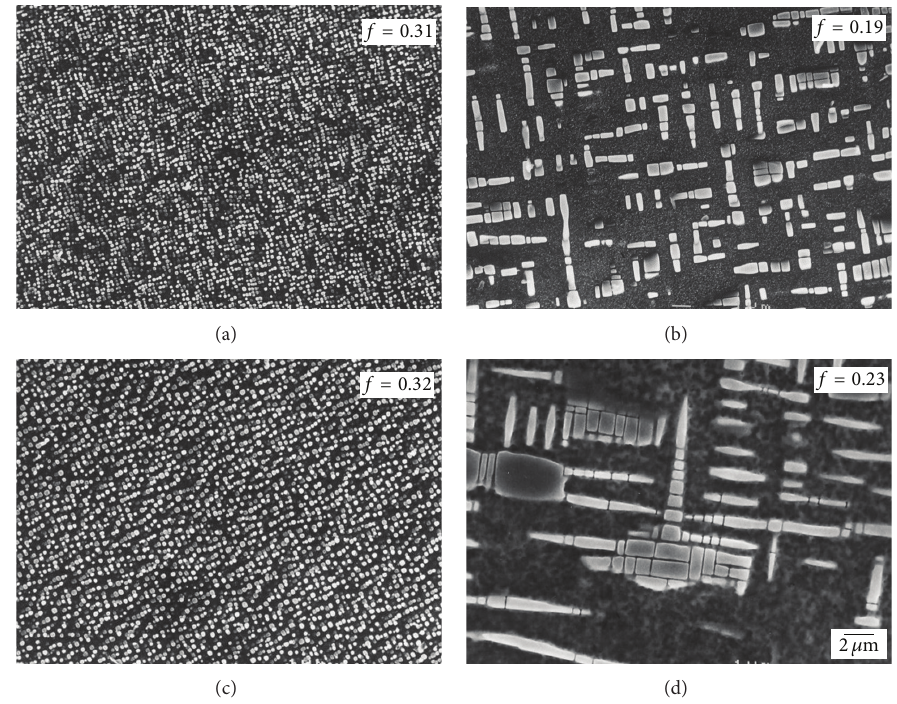
Figure 2: SEM micrographs of the Fe 0.74 Ni 0.10 Al 0.15 Cr 0.01 alloy aged at (a-b) 750 and (c-d) 950 ∘ C for 50 and 200 h,